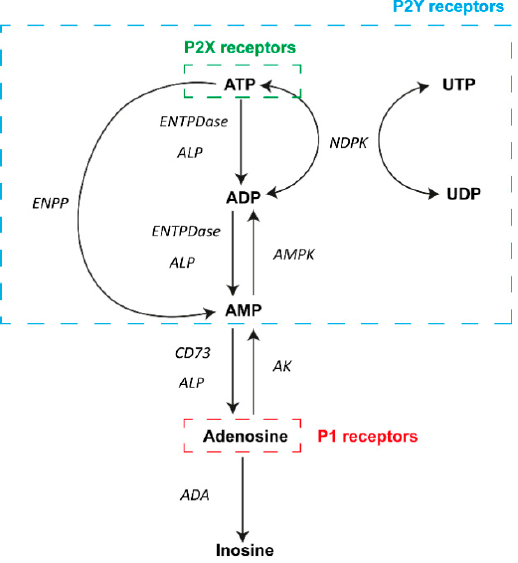
Figure 1. Diagram of the main elements of purinergic signaling. In the extracellular milieu, adenosine and nucleotides can activate P1 and P2 receptors on the surface of a wide variety of cell types. A number of different nucleotides can activate P2Y receptors (blue box), and ATP can also activate P2X receptors (green box). In contrast, adenosine actions involve the activation of P1 receptors (red box). Different enzymes are involved in the metabolism of adenosine and ATP in the process of achieving transient signaling. Abbreviations: adenosine triphosphate, ATP; adenosine diphosphate, ADP; adenosine monophosphate, AMP; uridine triphosphate, UTP; uridine diphosphate, UDP; ectonucleoside triphosphate diphosphohydrolase family, ENTPDase; alkaline phosphatase family, ALP; ectonucleotide pyrophosphatase/phosphodiesterase family, ENPP; ecto-5 ′ -nucleotidase, CD73; nucleoside diphosphate kinase, NDPK; AMP-activated protein kinase, AMPK; adenosine kinase, AK; adenosine deaminase, ADA.